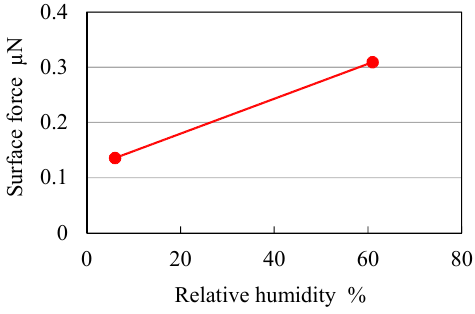
Figure 13. Relationship between relative humidity and surface forces.